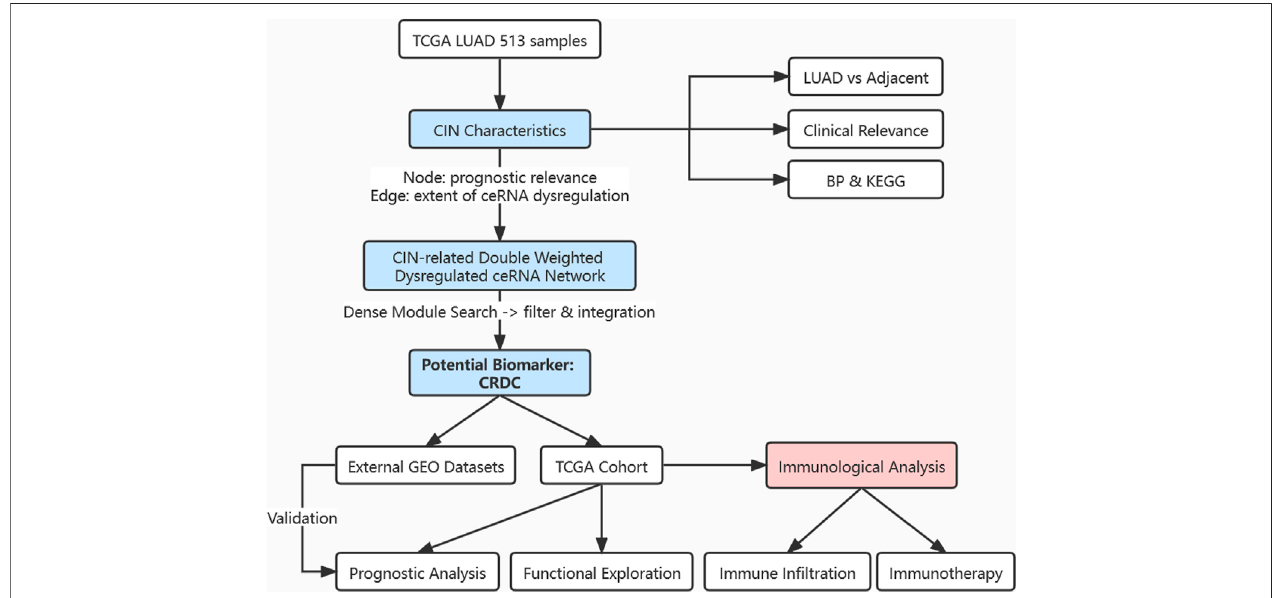
FIGURE 1 | Flowchart of this research. Exploration of CIN feature in expression level, clinical outcome relevance, and functional analysis; construction of a CIN- related double-weighted dysregulated ceRNA network; acquisition of a potential biomarker CRDC after dense module searching, fi ltering, and integration; analyzation and evaluation of CRDC in the prognostic value; inference for immune cell in fi ltration and bene fi t from immunotherapy.